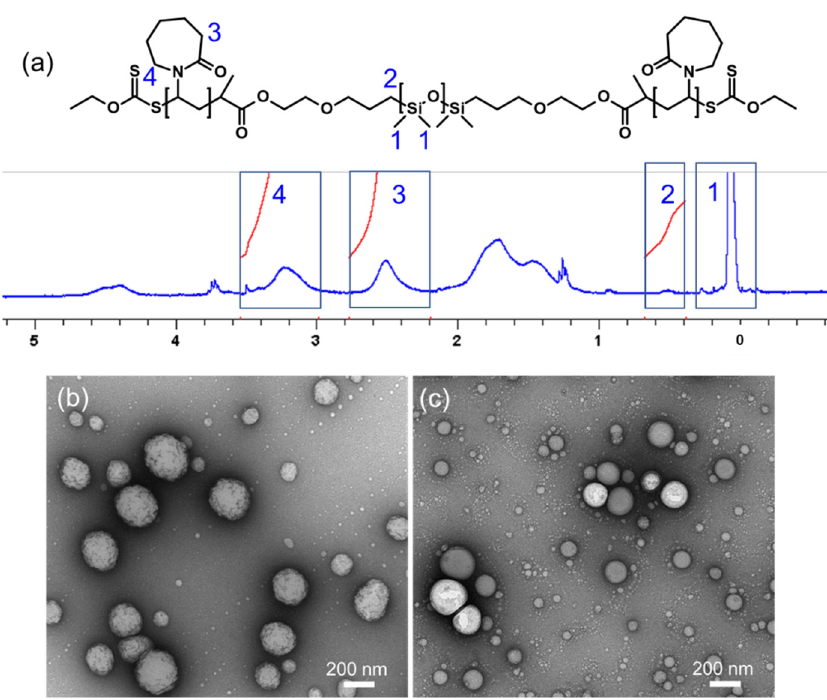
Figure 2. ( a ) The 1 H-NMR spectrum of PVCL 10 -PDMS 65 -PVCL 10 . TEM images of drug (DOX)-encapsulated (1 mg mL − 1 ) PVCL 10 -PDMS 65 -PVCL 10 ( b ) and DOX-encapsulated PMOXA 14 -PDMS 65 -PMOXA 14 ( c ) polymer vesicles.